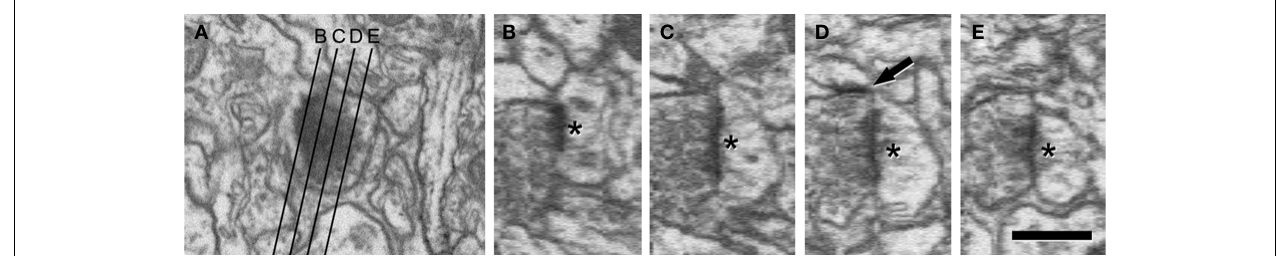
FIGURE 8 | A synapse digitally resliced trough a perpendicular plane of section. The synapse presented in (A) is the same that is shown in Figure 7E . Using the ImageJ software (see text) a stack of 50 sections containing the synapse was digitally resliced through a plane perpendicular to the original plane of section. Thus, the synapse that was previously sectioned en face in (A) was sectioned transversally in (B) to (E) . The lines on (A) indicate the position and orientation of the four selected sections shown in (B) to (E) . The synaptic junction can be identifi ed as a dense gray profi le in (B) to (E) (asterisks).